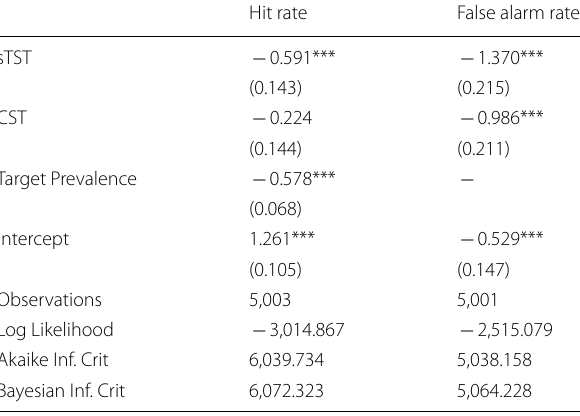
Table 2 Generalised linear mixed‑effects models comparing hit rate and false alarm rate in the standard (sTST) and combined search training (CST) groups with the target‑based search training group (standard errors in